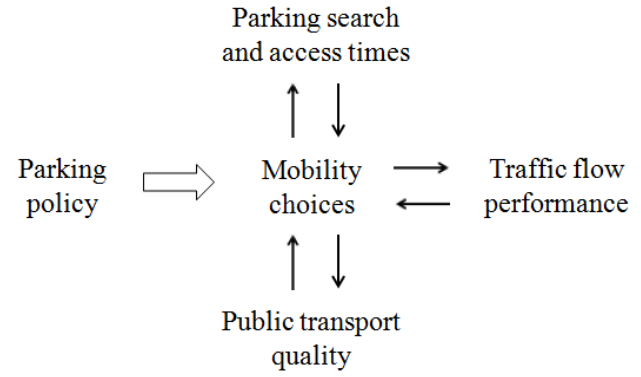
Figure 1. Outline of model